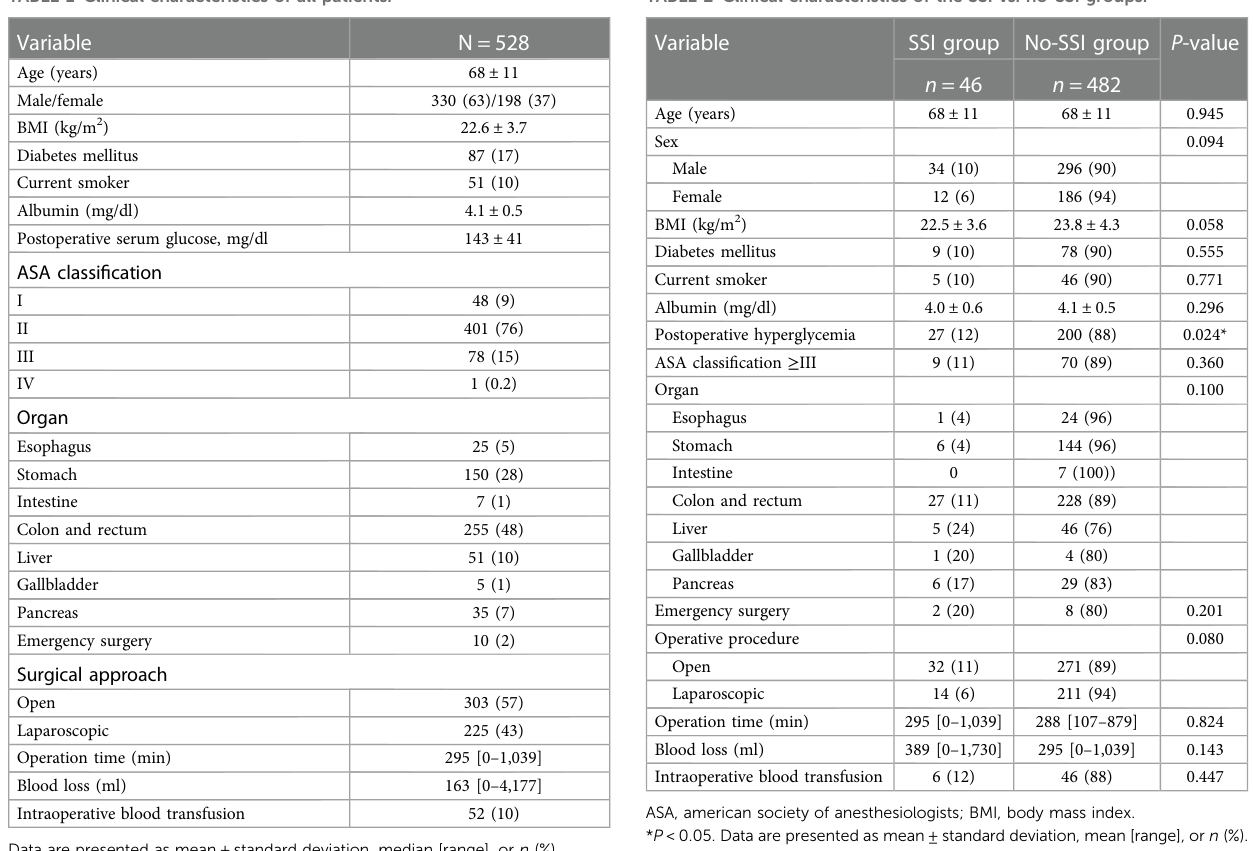
TABLE 1 Clinical characteristics of all patients. TABLE 2 Clinical characteristics of the SSI vs. no-SSI groups.